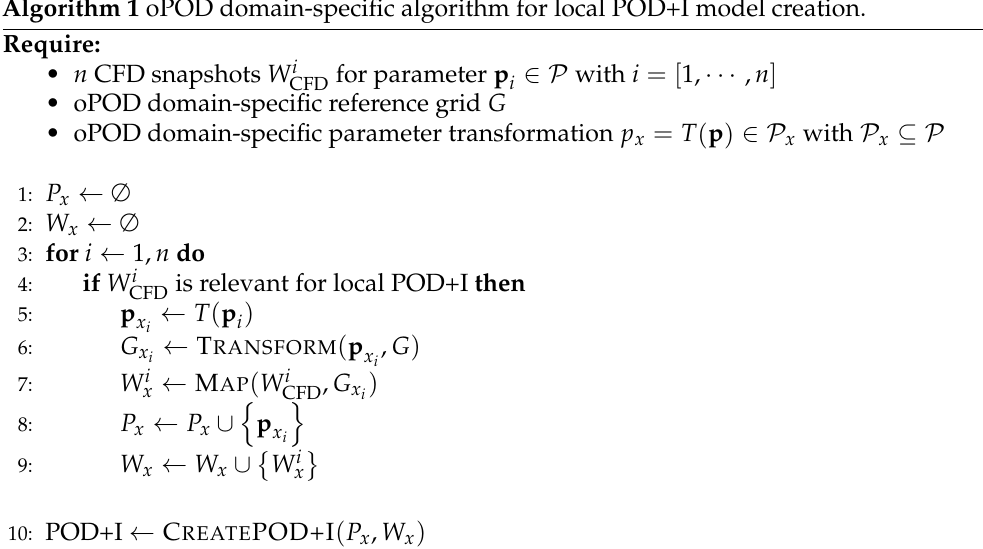
Algorithm 1 oPOD domain-specific algorithm for local POD+I model